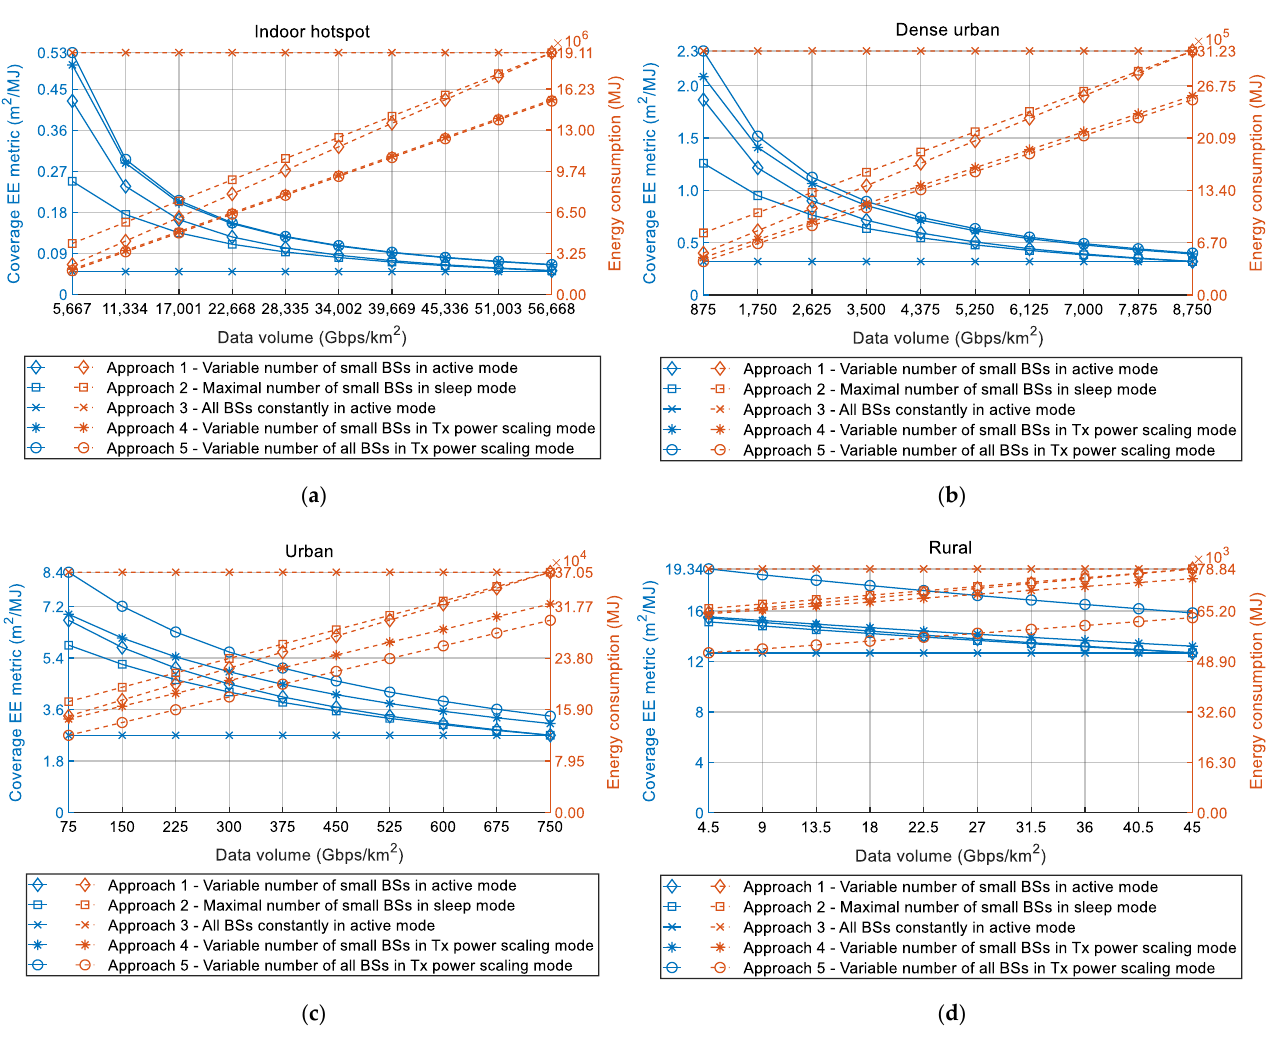
Figure 4. Impact of DV increase on coverage EE metrics and 5G network yearly energy consumption during the 2020s for ( a ) indoor-hotspot, ( b ) dense-urban, ( c ) urban and ( d ) rural device density class.